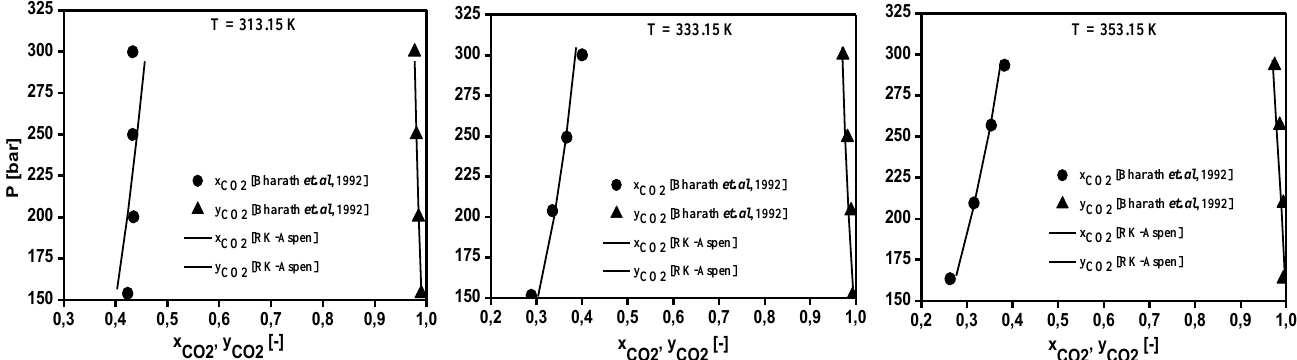
Figure 2. Experimental and predicted high-pressure phase equilibrium for the system oleic acid-CO 2 (Bharath et al., 1992).